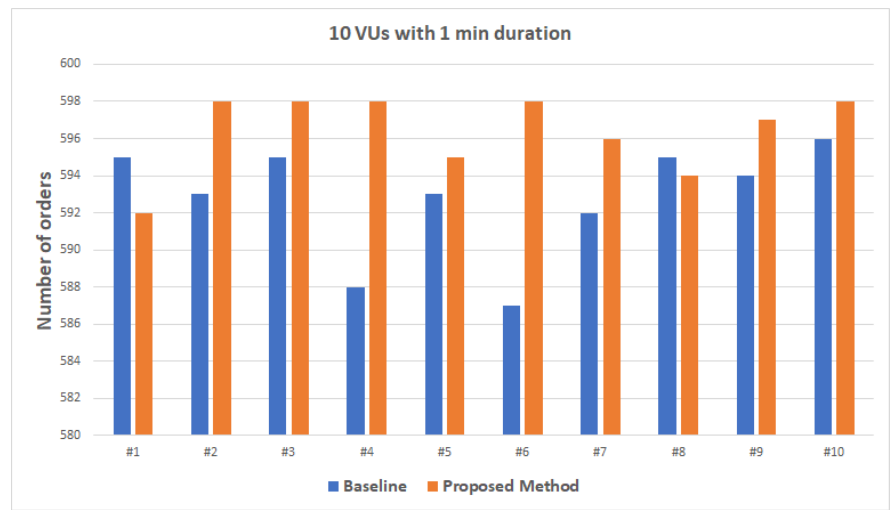
Figure 14. Load Testing—10 virtual users with 1 min duration.